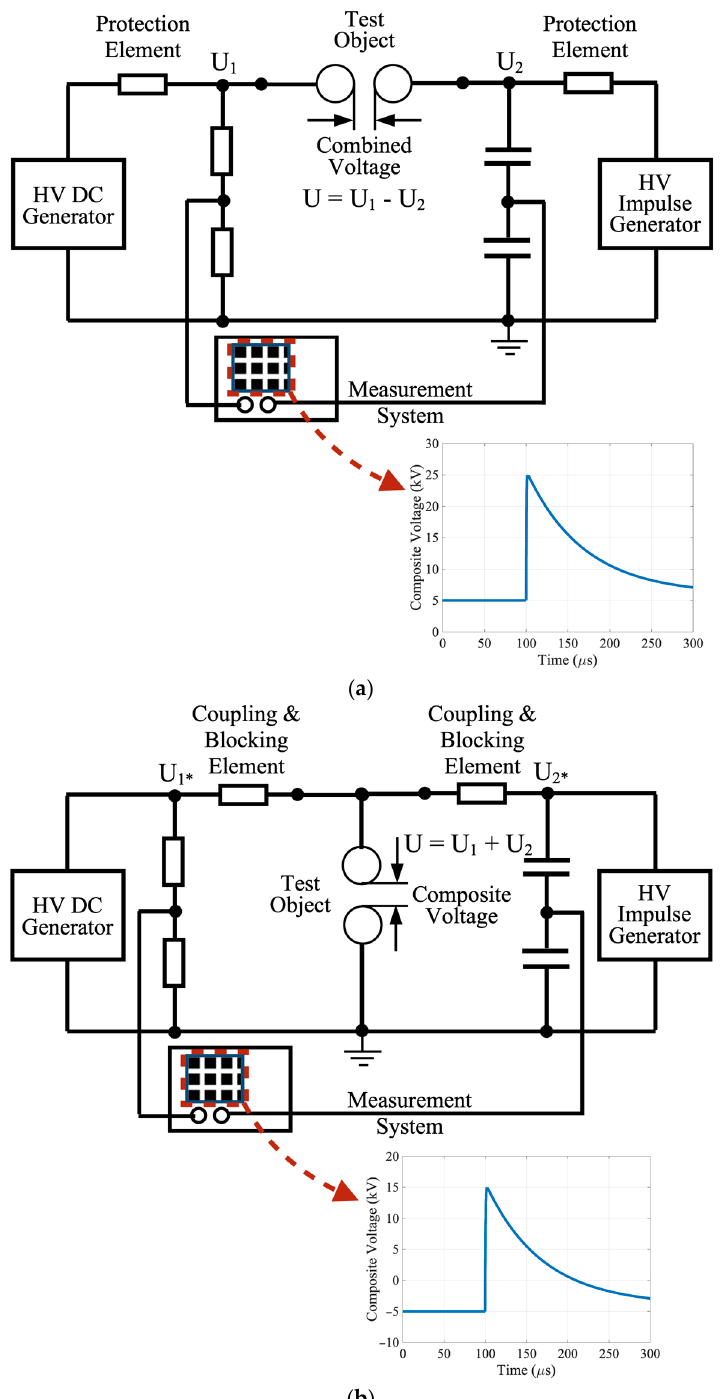
Figure 2. The generation and measurement test circuit: ( a ) combined voltage; ( b ) composite voltage.